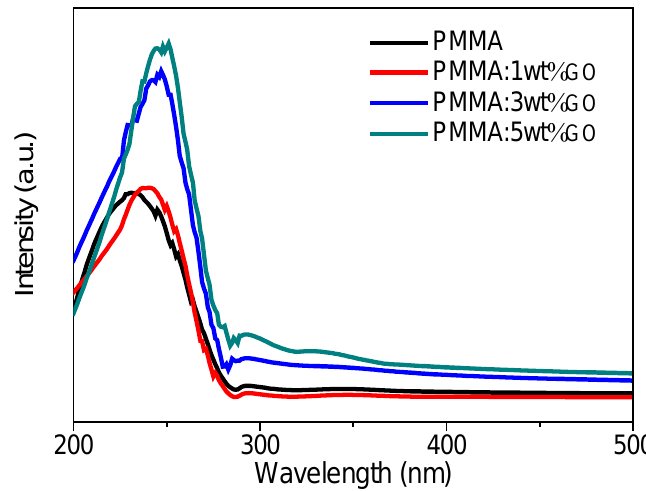
Figure 5. UV-vis absorption spectra of pure PMMA, and PMMA: 1 wt % GO, PMMA: 3 wt % GO, and PMMA: 5 wt % GO composite solutions.